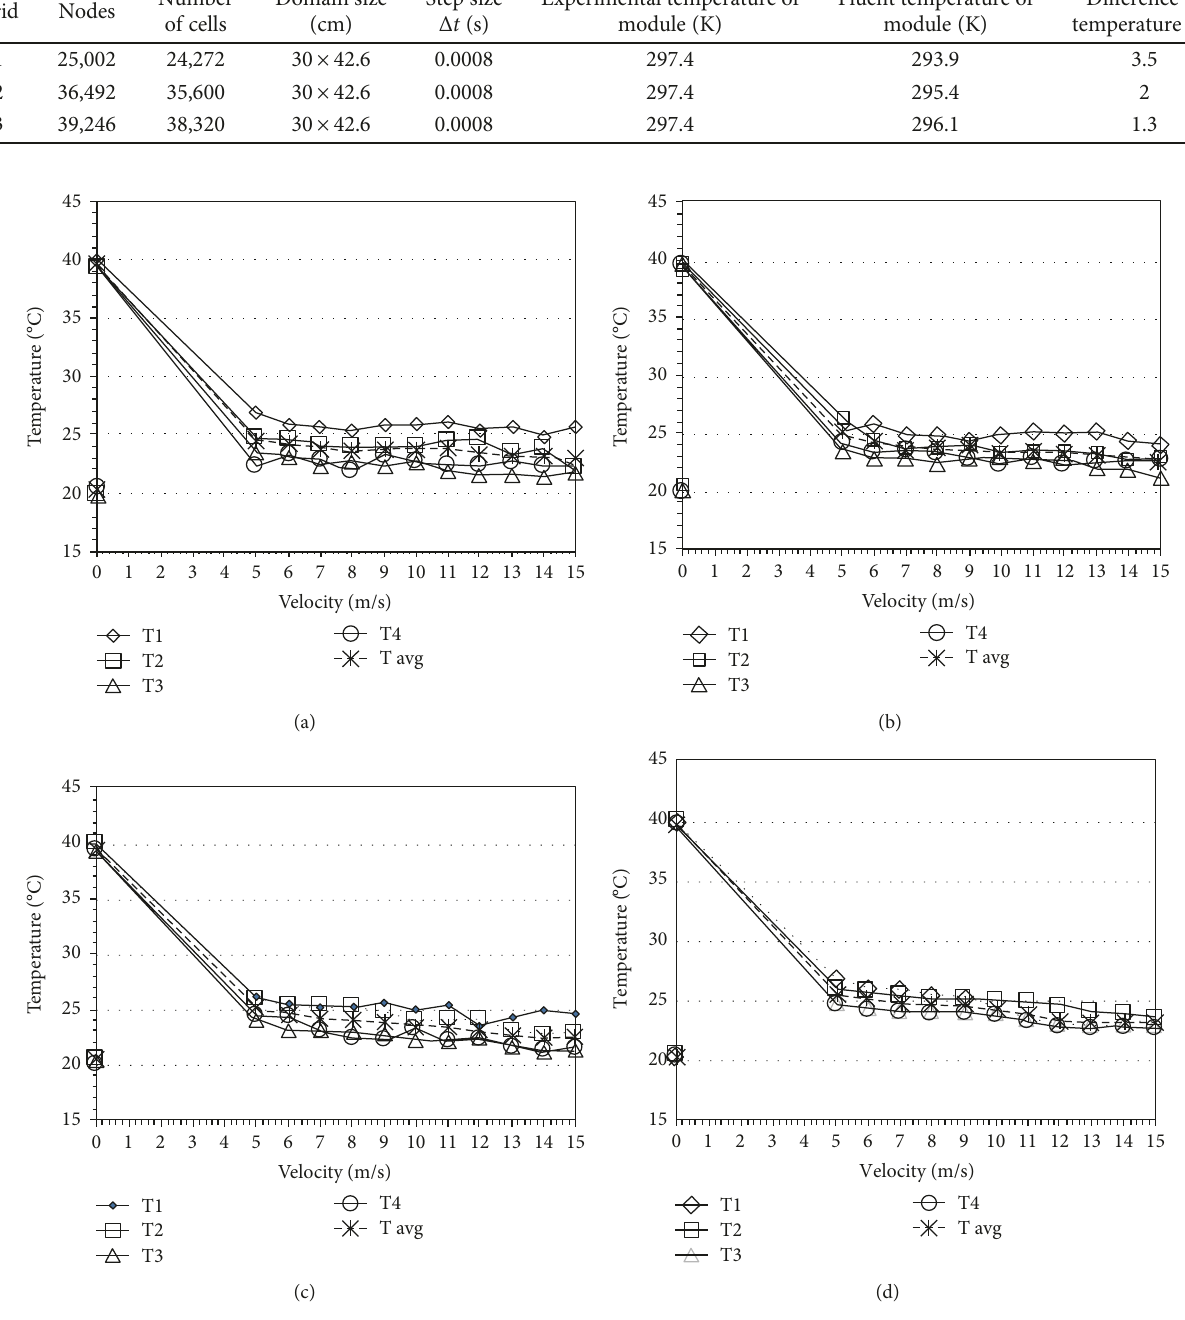
Figure 4: Variation of temperature with velocity. (a) Monocrystalline at 0 ° , (b) monocrystalline at 10 ° , (c) polycrystalline at 0 ° , and (d) polycrystalline at 10 °